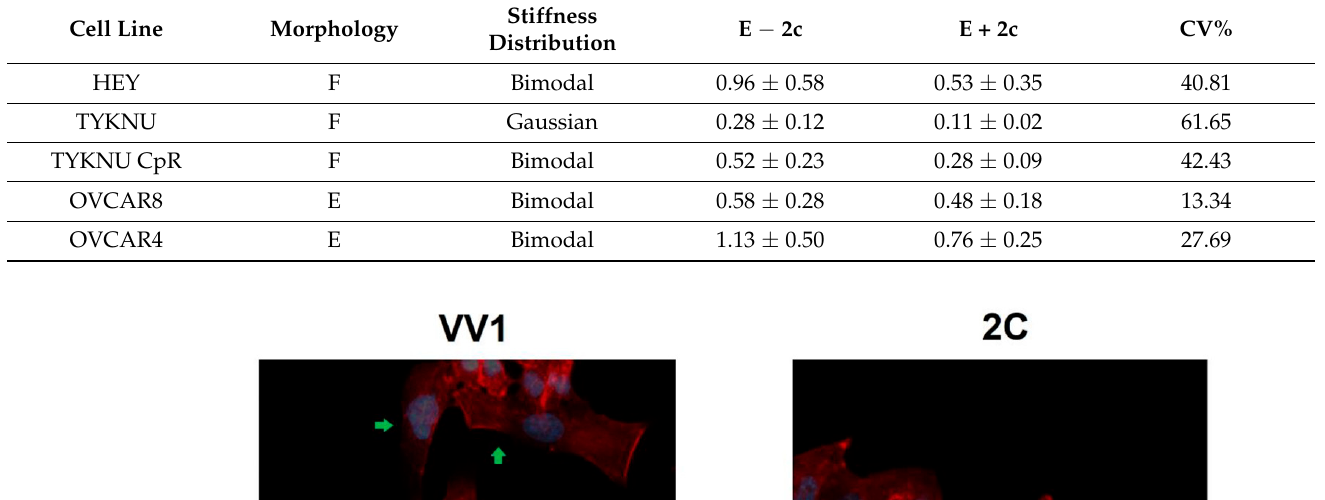
Table A1. Average Young’s modulus of cell lines before (E − 2c) and after (E + 2c) 2c treatment and corresponding coefficient of variation (CV%). F: Fibroblast, E: Epithelial.